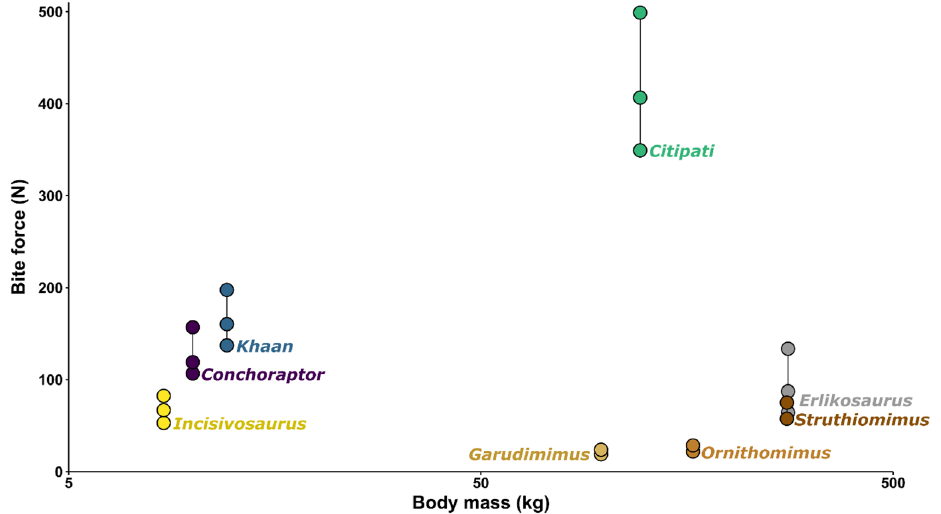
Figure 5. Comparison of the estimated bite forces in multiple positions of Incisivosaurus and three oviraptorid oviraptorosaurians with other likely herbivorous theropod taxa that have had estimates made using similar digital volumetric methods 12,13 show the oviraptorosaurians (oviraptorids especially) are capable of much stronger bite forces both relative to body mass and absolutely. Body mass values from Zanno and Makovicky 11